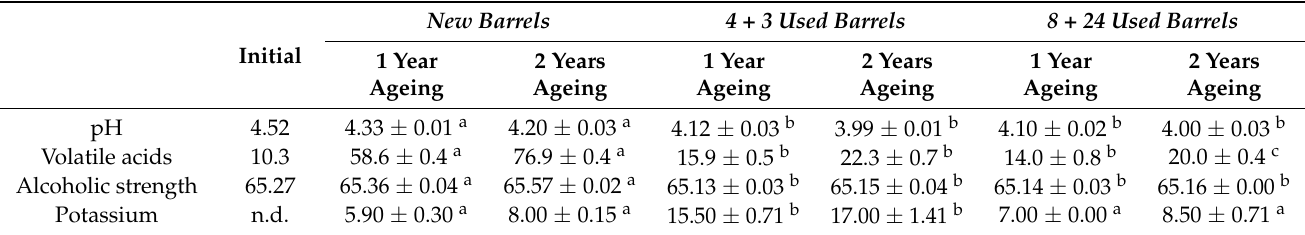
Table 3. pH, alcoholic strength (% Alcohol by Volume, ABV), volatile acids (mg acetic acid/100 mL of 100% vol. alcohol) and potassium (mg/L) of brandies aged for one or two years in New barrels , 4 + 3 Used barrels , and 8 + 24 Used barrels .